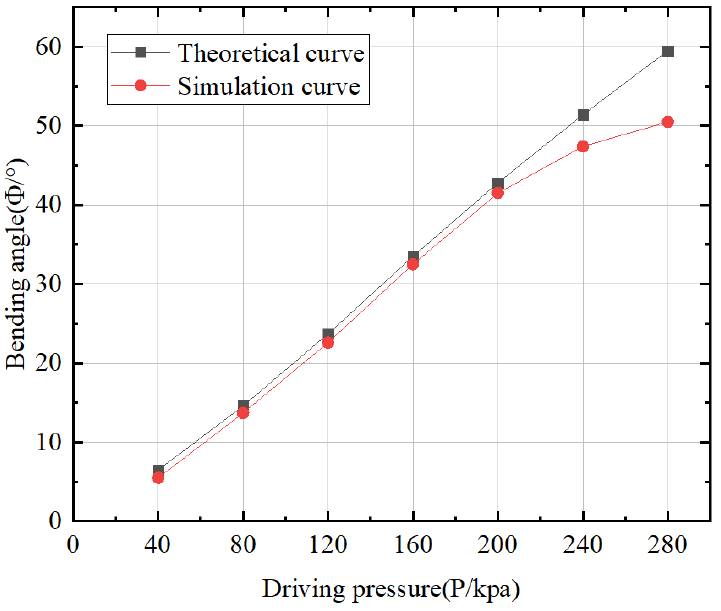
Figure 8. Comparison between simulation curve and the theoretical curves.